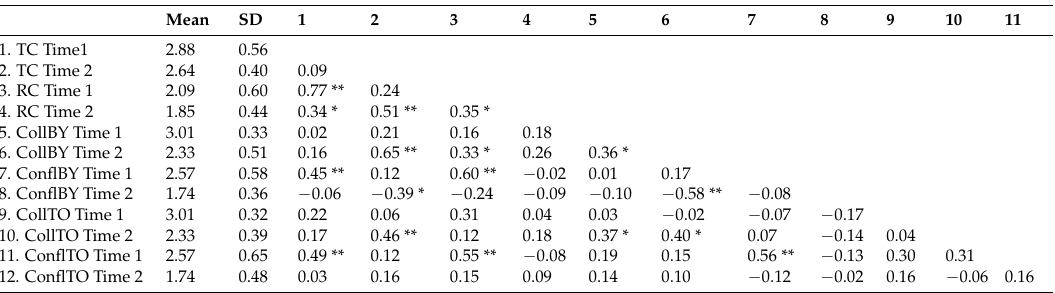
Table 1. Presents the means, standard deviations and correlations among the variables used in further analyses. Mean SD